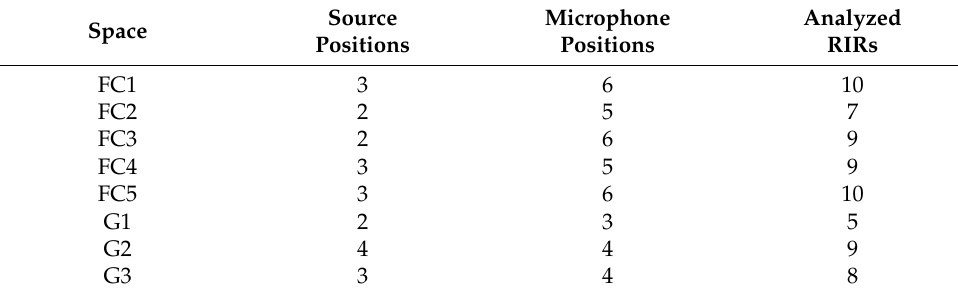
Table 3. Number of analyzed room impulse responses (RIRs).